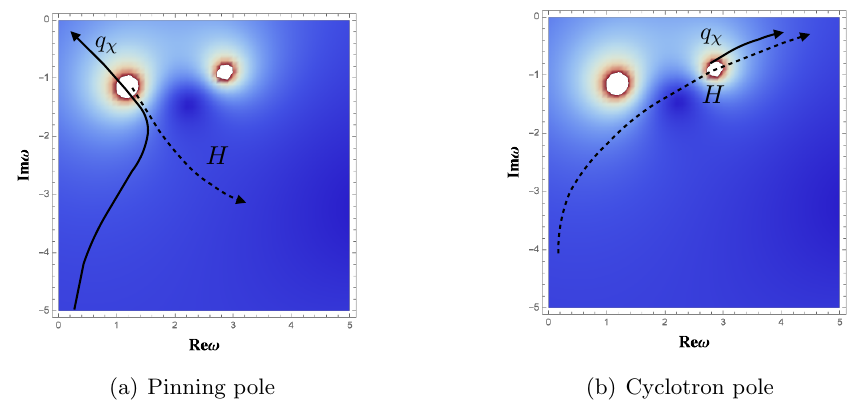
Figure 5 . The evolution of the quasi-normal mode as q increases. (a) For the pinning pole and (b) For the cyclotron pole. In both (cid:12)gures (cid:12)=T = 3, q (cid:31) = 10 and H=T 2 =